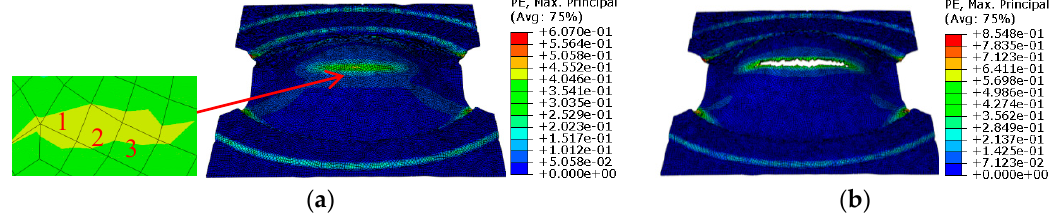
Figure 7. Strain states before and after fracture ( a ) before fracture; ( b ) after fracture.